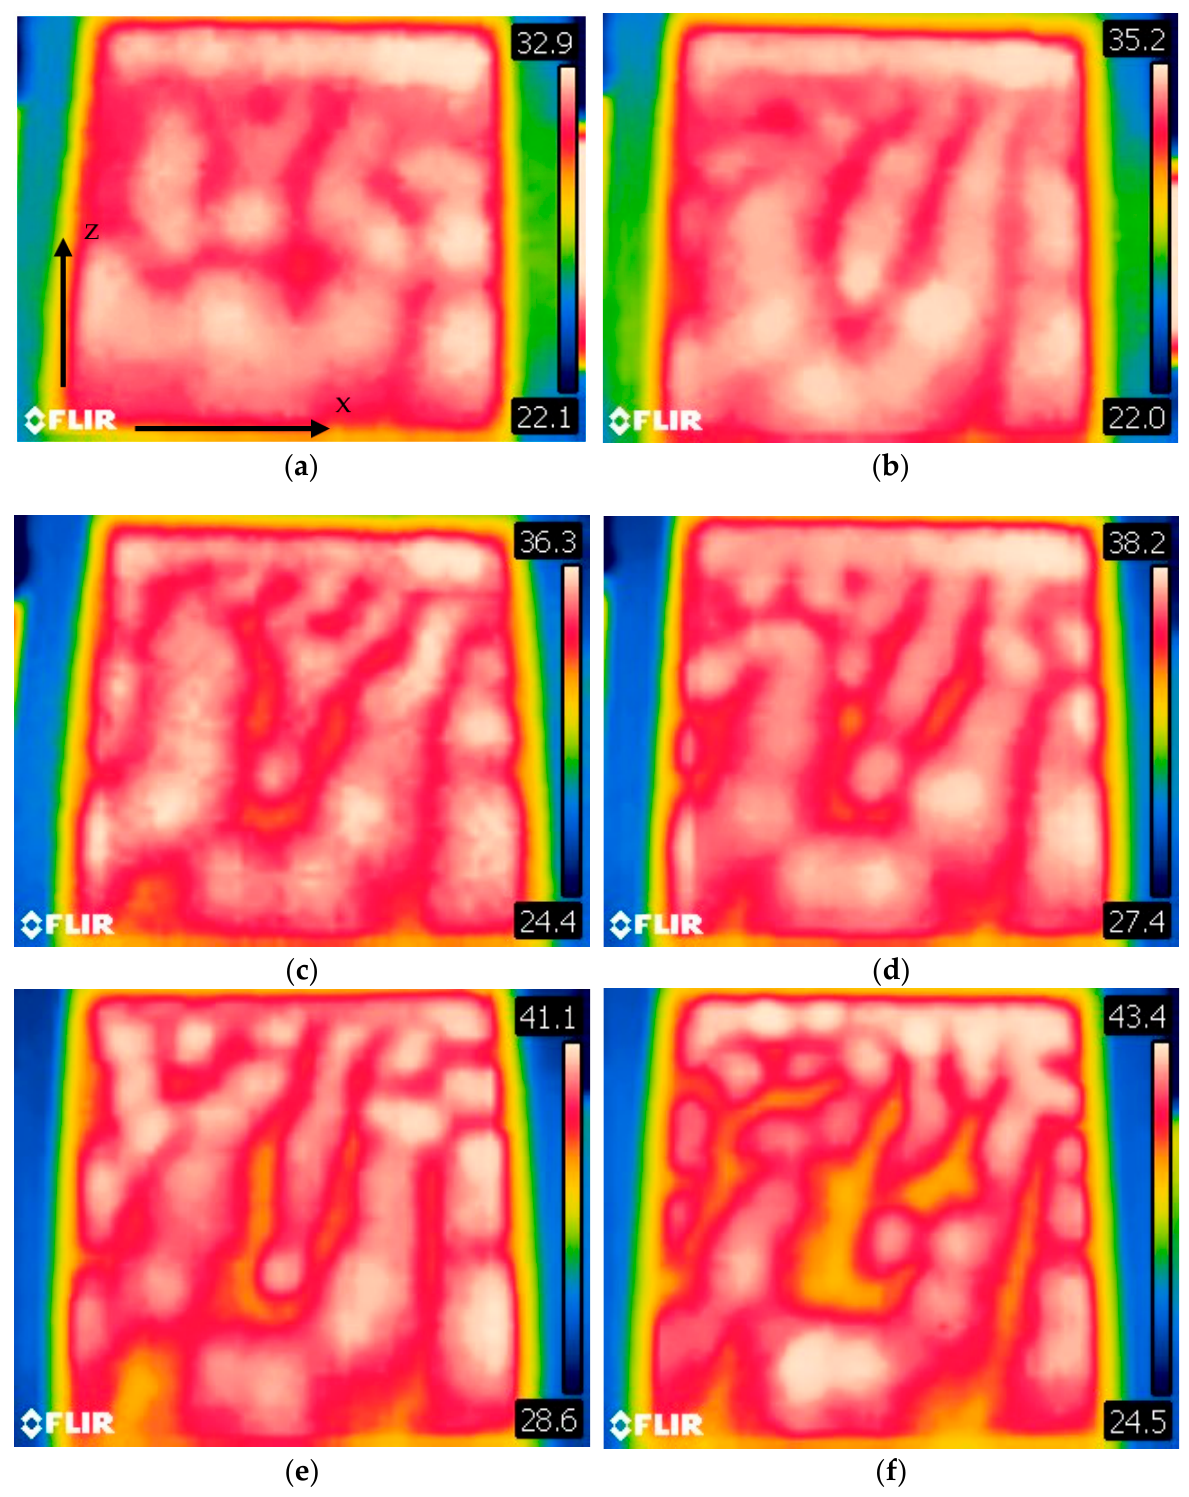
Figure 11. Surface temperature distribution for d = 0.75 cm ( Ω = 48 mL) and ϑ ≅ 5° ( A = 10.6, Bo dyn ≅ 1.94, Ra ≅ 8.6 × 10 2 × ∆ T , Ma ≅ 4.4 × 10 2 × ∆ T ) ( a ) ∆ T = 15 °C, ( b ) ∆ T = 18 °C, ( c ) ∆ T = 21 °C, ( d ) ∆ T = 24 °C, ( e ) ∆ T = 27 °C, ( f ) ∆ T = 30 °C (the x and z axes correspond to the horizontal and vertical directions in all the panels).